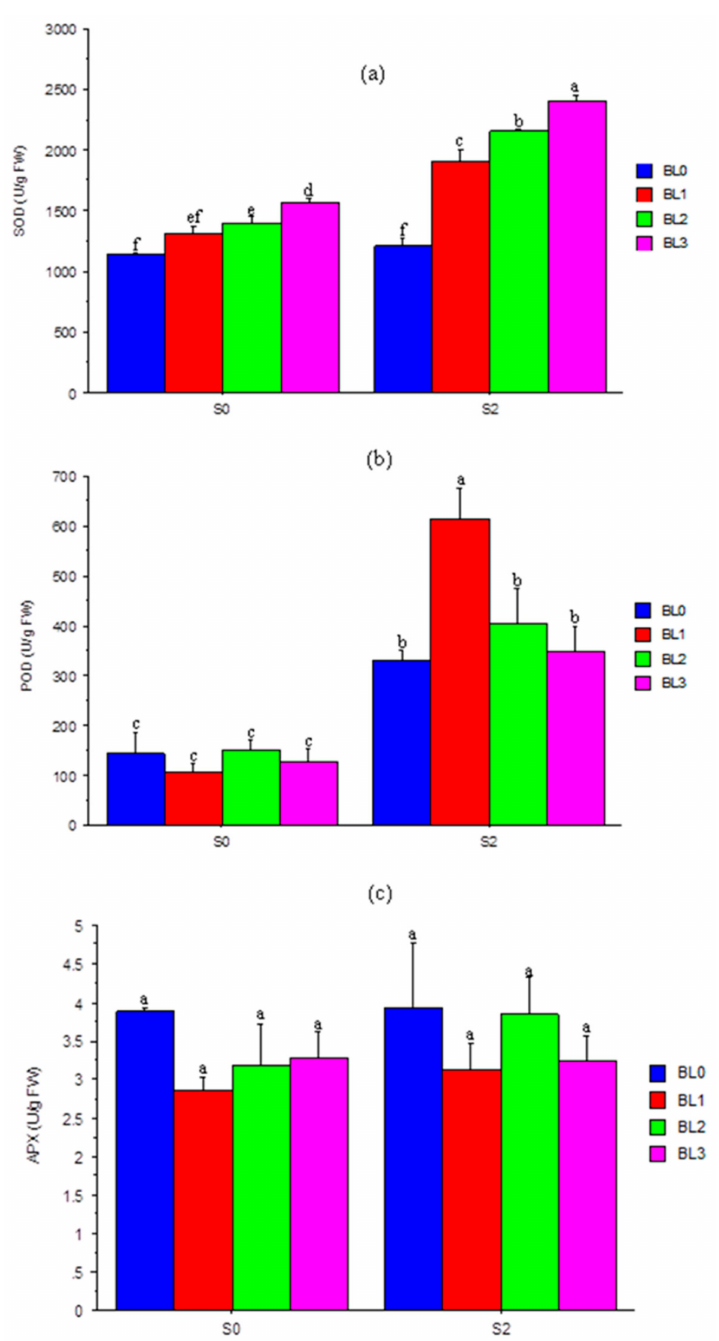
Figure 6. Interaction effects of salinity × brassinolide on the activity of SOD ( a ), POD ( b ) and APX ( c ) of soybean leaves at flowering growth stage. SOD—superoxide dismutase; POD—peroxidase; APX— ascorbate peroxide; BL—brassinolide; Scheme 0. BL application at seedling; BL2—BL application at flowering; BL3—BL application at seedling + flowering; S0—1.10 mM/L (control); S2—60.60 mM/L. Mean pairs with different letters are significantly different at the 5% probability level according to Duncan’s new multiple-range